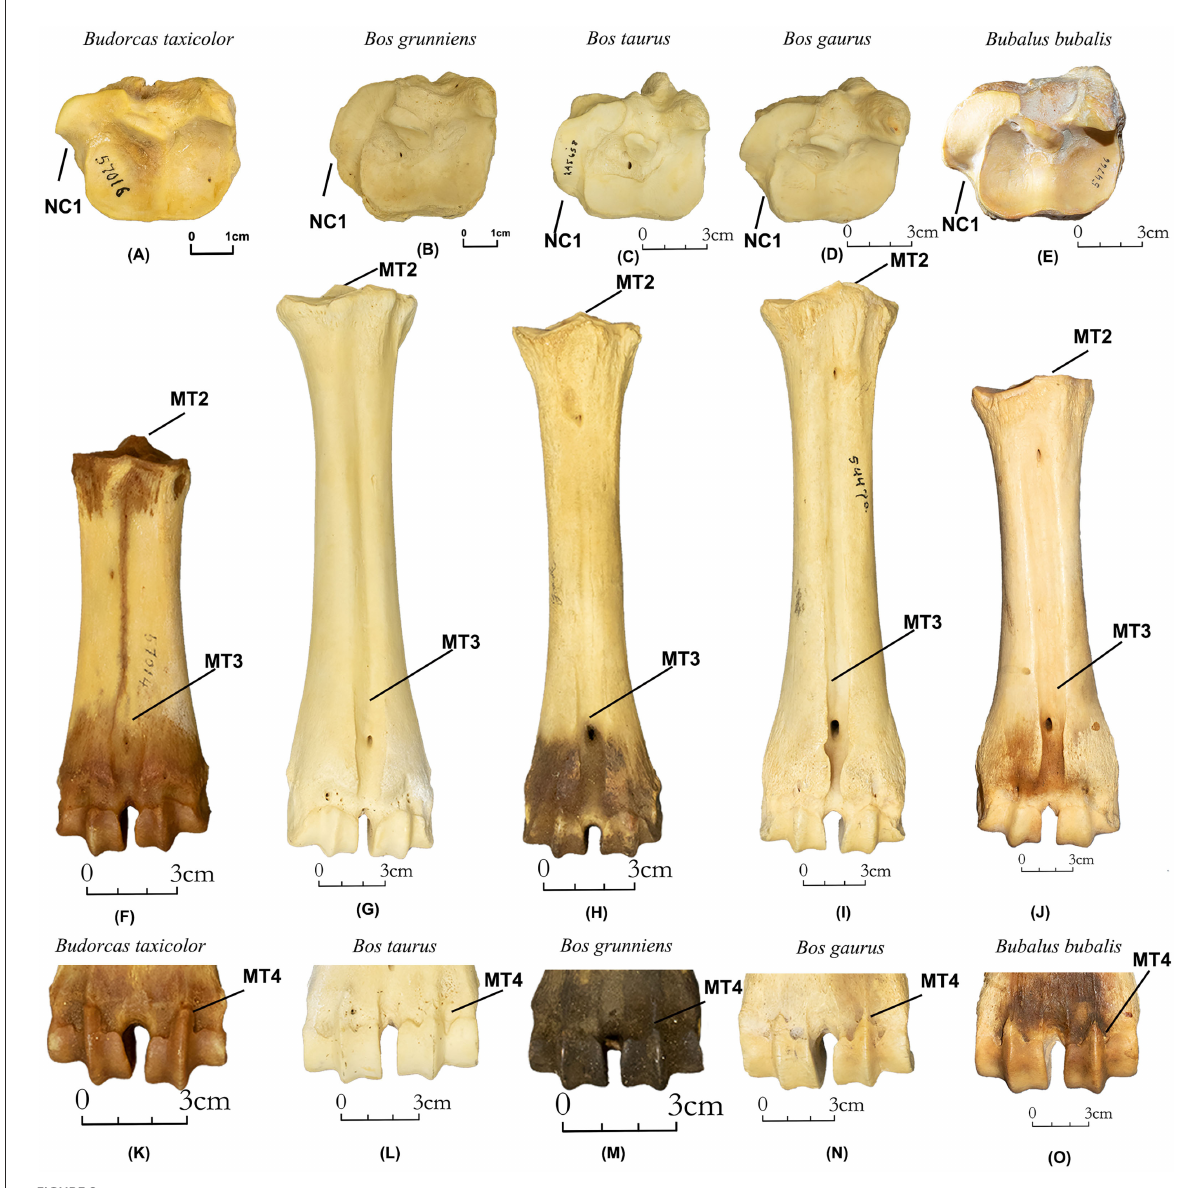
FIGURE8 Navicular-cuboid and metatarsal of takins and Bovini. Proximal view of navicular-cuboid: (A) Budorcas taxicolor (AMNH–M − 57016), (B) Bos grunniens (AMNH–MO − 10263). (C) Bos taurus (AMNH–M − 100031). (D) Bos gaurus (AMNH–M − 112979). (E) Bubalus